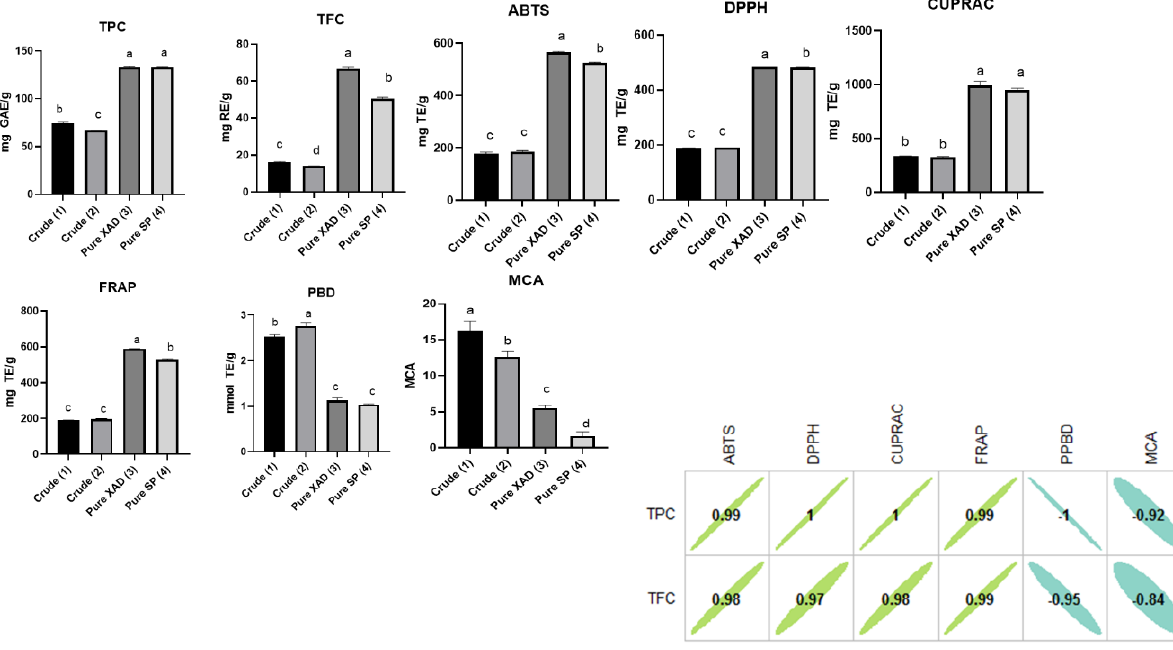
Figure 1. Total phenolic (TPC), flavonoid (TFC), and antioxidant properties and Pearson’s correlation between total bioactive compounds and antioxidant properties (PPBD: Phosphomolybdenum; MCA: Metal chelating activity). GAE: Gallic acid equivalent; RE: Rutin equivalent; TE: Trolox equivalent; EDTAE: EDTA equivalent. Values expressed are means ± S.D. of three parallel measurements. Different letters indicate significant differences in the extracts ( p <